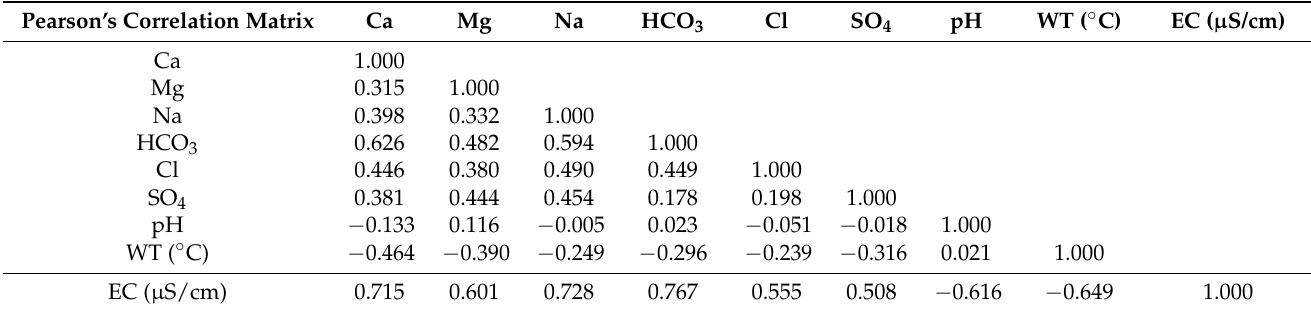
Table 3. Correlation matrix of input variables corresponding to